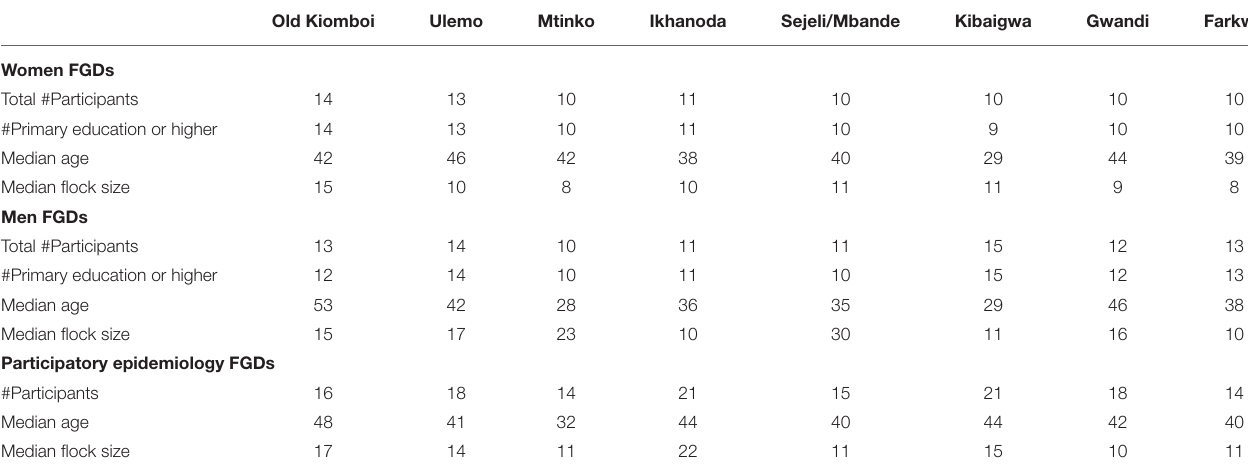
TABLE 4 | Socio-economic make up of focus group participants in Tanzania * . Old Kiomboi